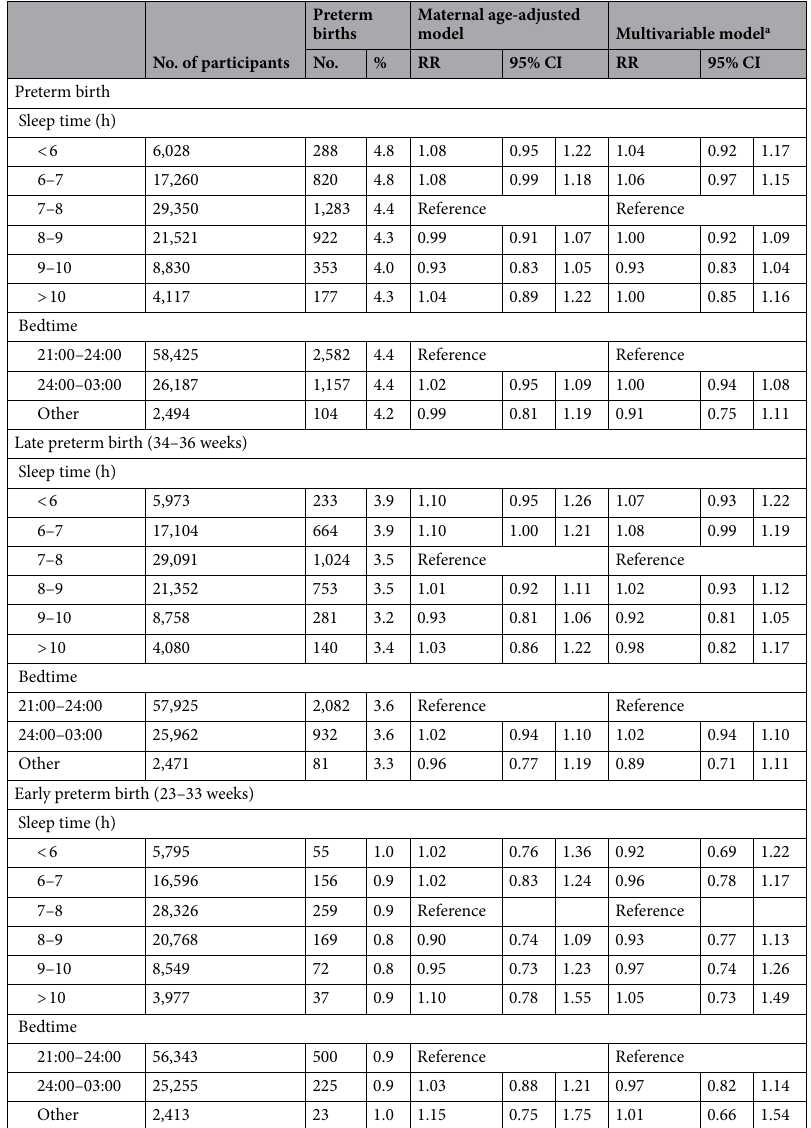
Table 2. Association between sleep during preconception and preterm birth in the Japan Environment and Children’s Study (2011–2014). CI, confidence interval; RR, relative risk. a Adjusted for maternal age at delivery, smoking habits, alcohol consumption, pre-pregnancy body mass index, parity, current history of diabetes or gestational diabetes, hypertensive disorders in pregnancy and intrauterine infection, history of preterm birth, and infertility